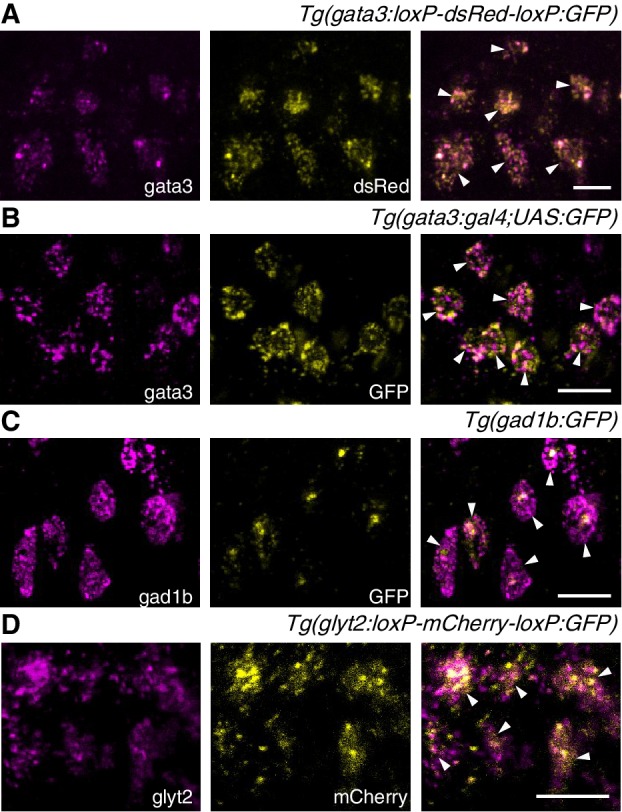
Two-color fluorescent in-situ hybridization validates transgenic line expression patterns.Confocal images (z-projection of ~5 µm) showing fluorescent in-situ hybridization for endogenous RNA (magenta, left), transgenic fluorophore (yellow, middle) and overlaid two-color image (right). White arrowheads indicate colocalization. (A) Tg(gata3:loxP-dsRed-loxP:GFP); (B) Tg(gata3:Gal4; UAS:GFP); (C) Tg(gad1b:GFP); (D) Tg(glyt2:loxP-mCherry-loxP:GFP). Scale bars = 10 μm.